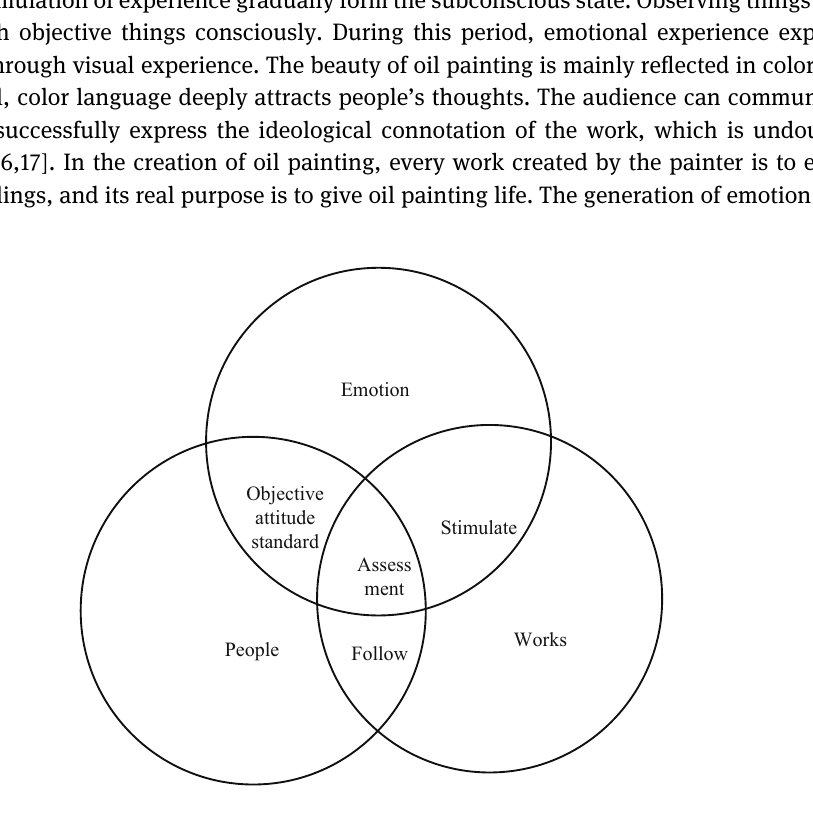
Figure 3: Correlation characteristics of in fl uencing factors of color emotional information